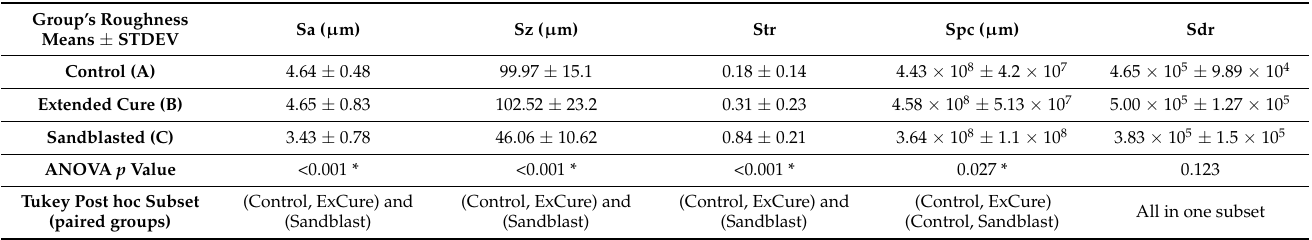
Table 1. Comparison of the surface parameter means for the three groups and the statistical signifi- cance ( p < 0.05). STDEV: standard deviation.